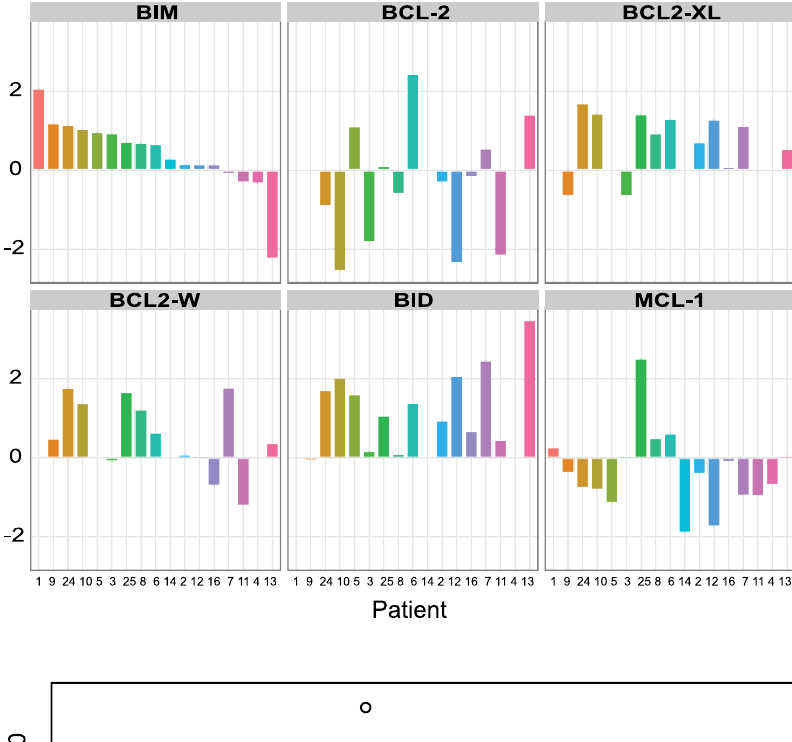
PLOS ONE | www.plosone.org